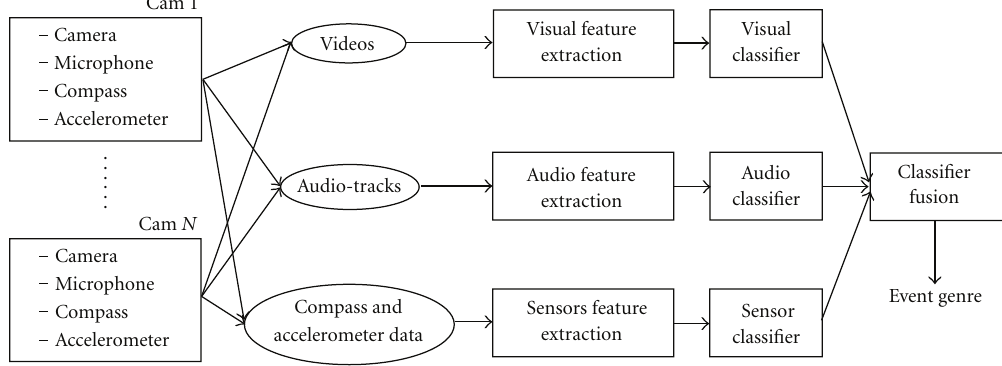
Algorithm 1: Layout classification based on camera locations.